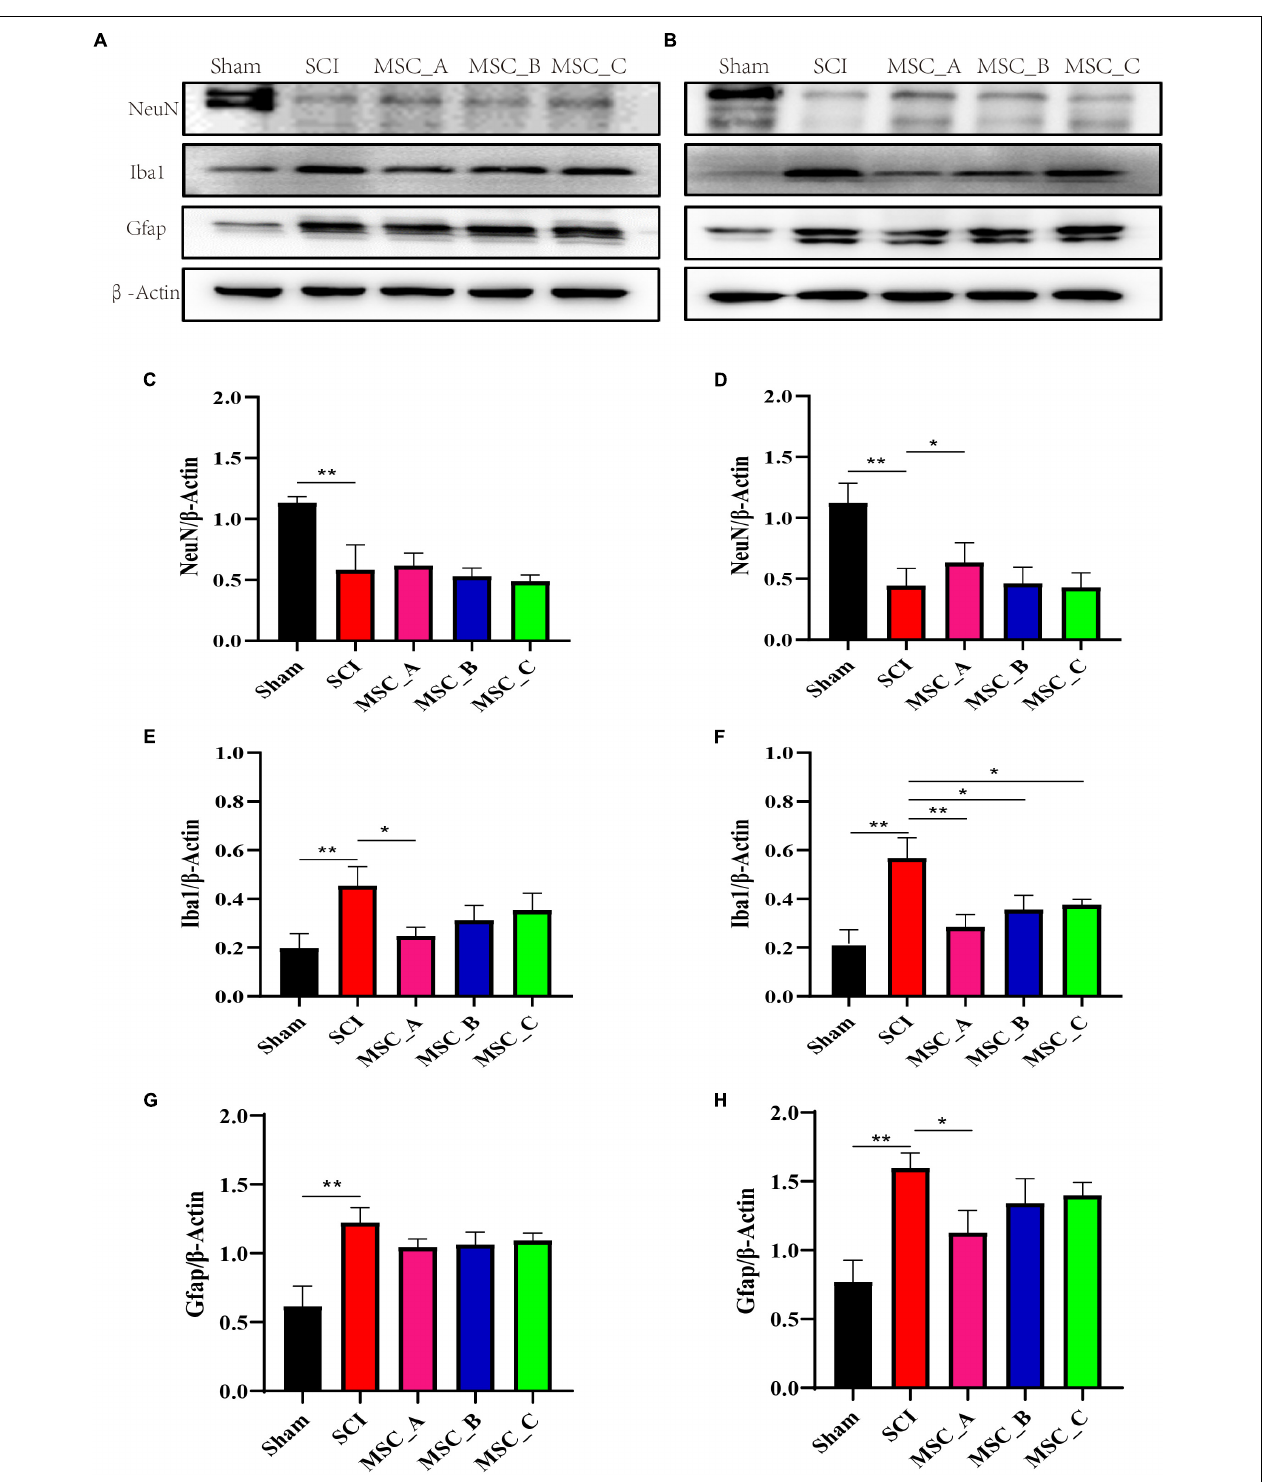
FIGURE 3 | Proteins related to SCI were detected at 1 week and 1 month after hUCMSC treatment at dpo 3. Western blot assay of neuronal nuclei (NeuN), glial fibrillary acidic protein (Gfap), and ionized calcium binding adaptor molecule 1 (Iba1) expressions at 1 week (A) and 1 month (B) after hUCMSC transplantation. Relative quantitative comparison of interest protein bands that were standardized by β -actin at 1 week (C,E,G) and 1 month (D,F,H) after hUCMSC transplantation. All data are presented as the mean ± SEM; n = 3; * p < 0.05; ** p < 0.01.